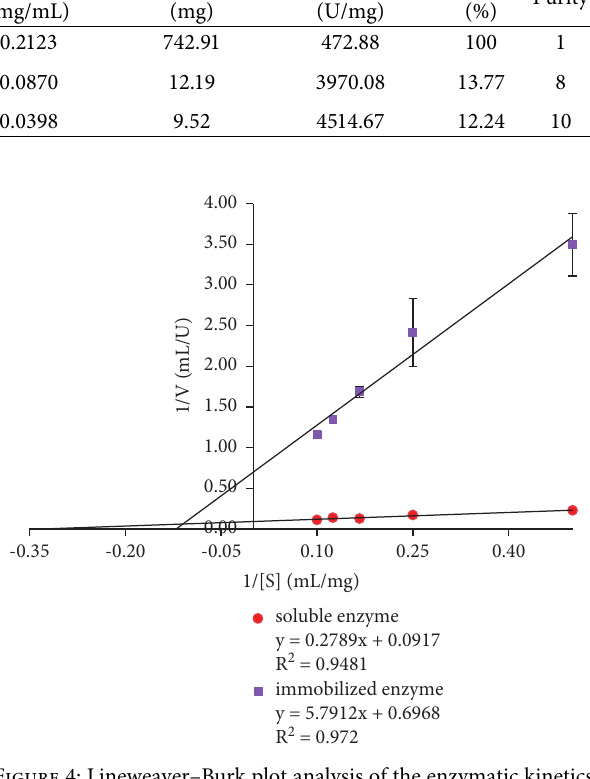
Figure 4: Lineweaver–Burk plot analysis of the enzymatic kinetics of soluble and immobilized enzyme. The values were presented as mean ± SD; n � 2; a significant difference � p < 0 . 05. The error bars represent standard deviations from two